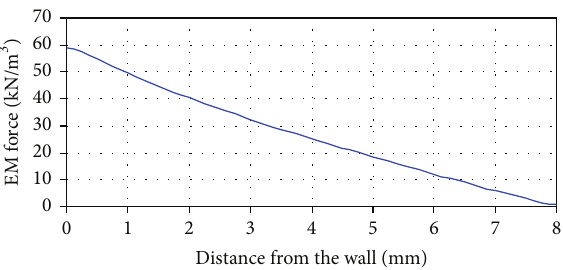
Figure 4: Drop in the density of the Lorentz electromagnetic force dependent on the distance from the cast wall on the side of the inductor (AlSi12CuMg alloy, frequency 1500 Hz).